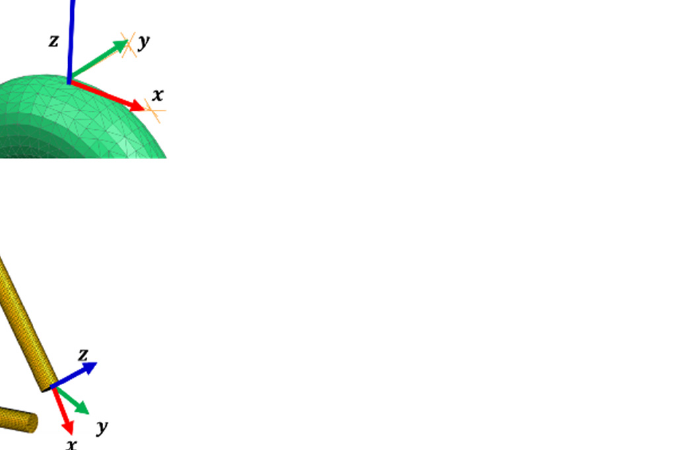
Figure 3. Boundary condition—restricting the translational movement on the 3 axes in the grip area.